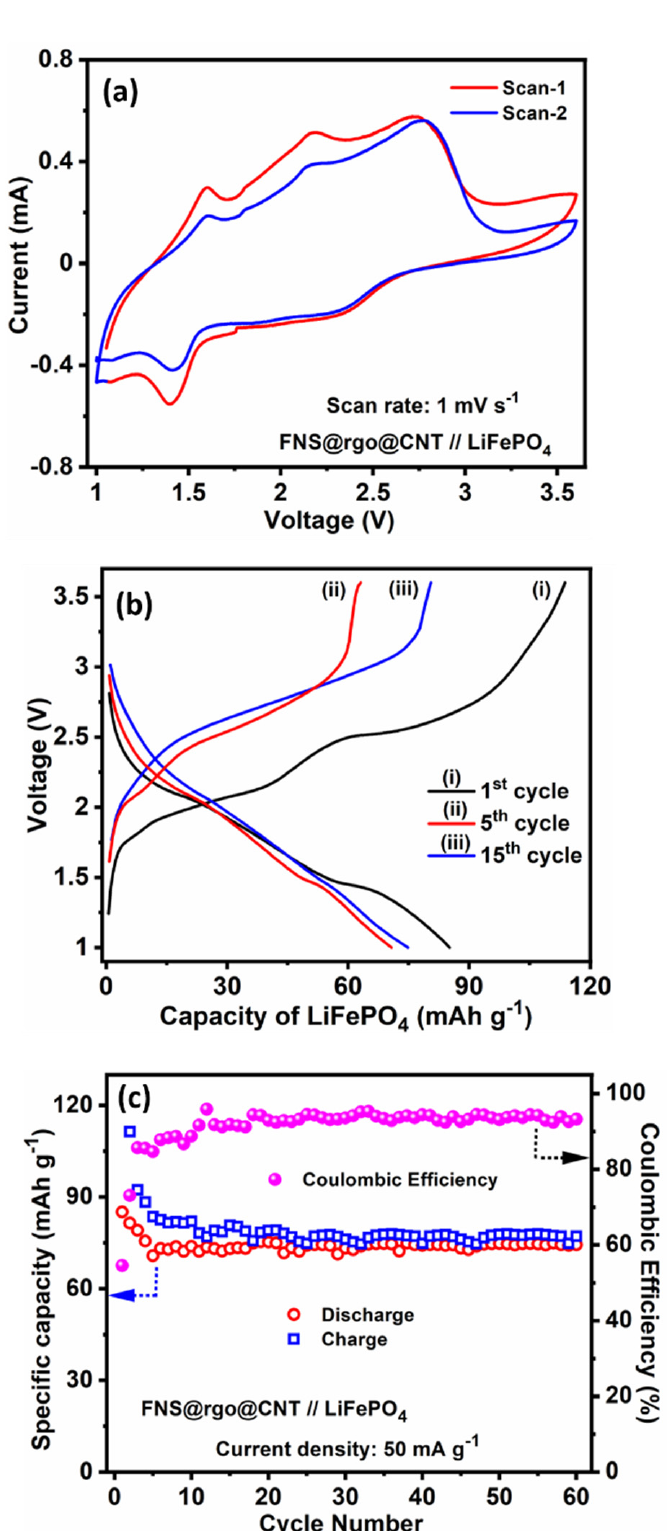
Figure 7. Full-cell LIB performance of FNS@GC electrode as anode and LiFePO 4 as cathode, ( a ) cyclic voltammogram (CV) for two cycles at 1 mV s − 1 scan rate at 1.0–3.6 V voltage window, ( b ) galvanos- tatic charge-discharge curves for 1st, 5th, 15th cycles at 100 mA g − 1 current density within 0.1–3.6 V, and ( c ) cycling stability performance at 50 mA g − 1 current rate.